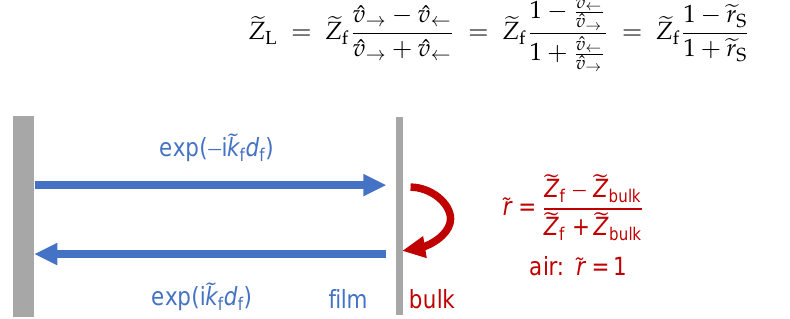
Figure 15. The stress at the surface of a resonator coated with a film contains a contribution from the reflected wave. for a film in air is sketched in Figure 15. r S